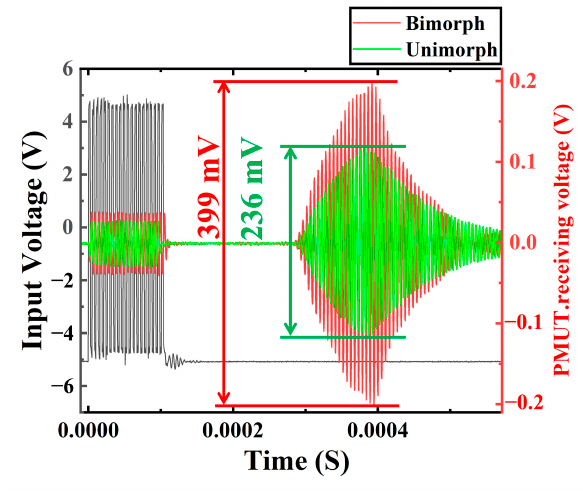
Figure 12. Device characterization for performance of receiver.